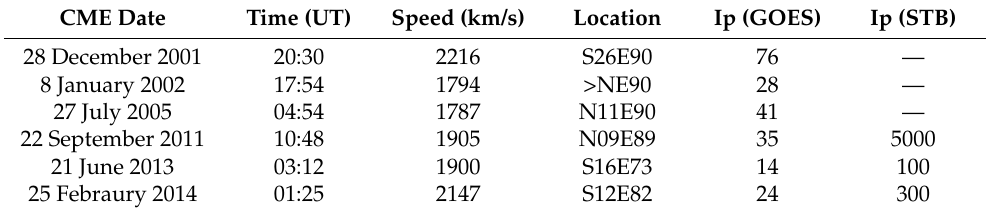
Table 2. CME speeds and SEP intensities of east-limb events observed by GOES and STB.